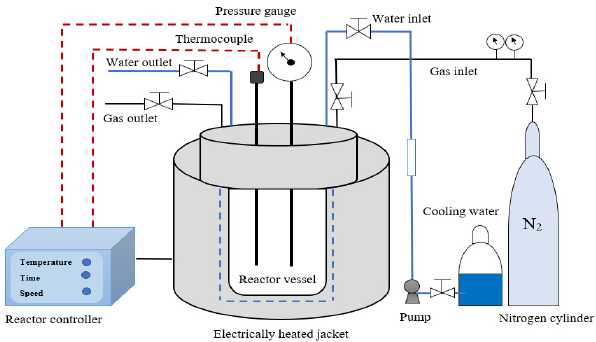
Figure 6. Subcritical water extraction apparatus.